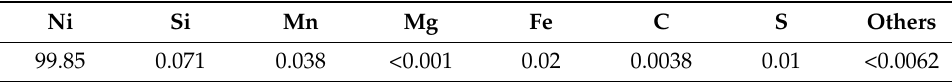
Table 1. Chemical composition of BM (base metal) (wt